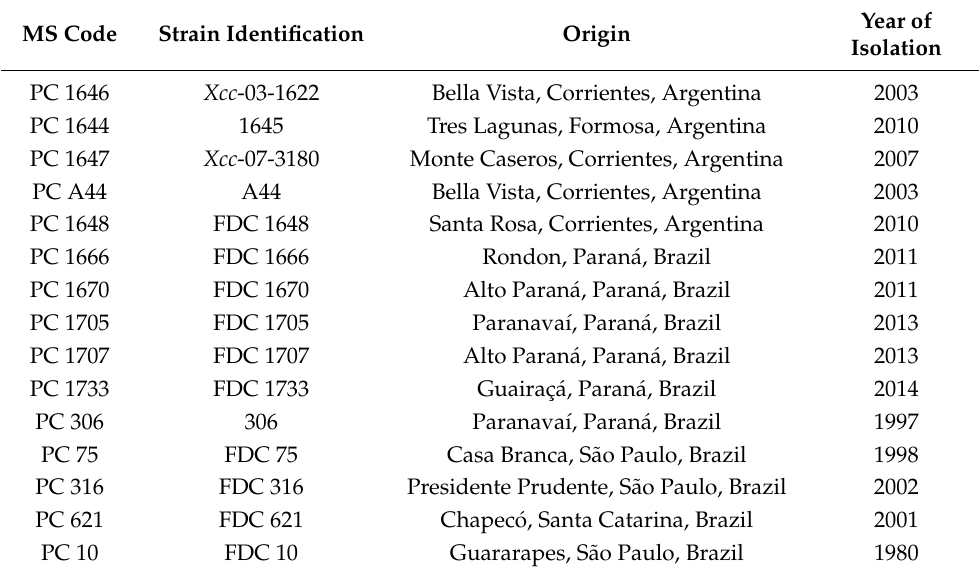
Table 1. Code for mass spectrometry and strains of Xcc